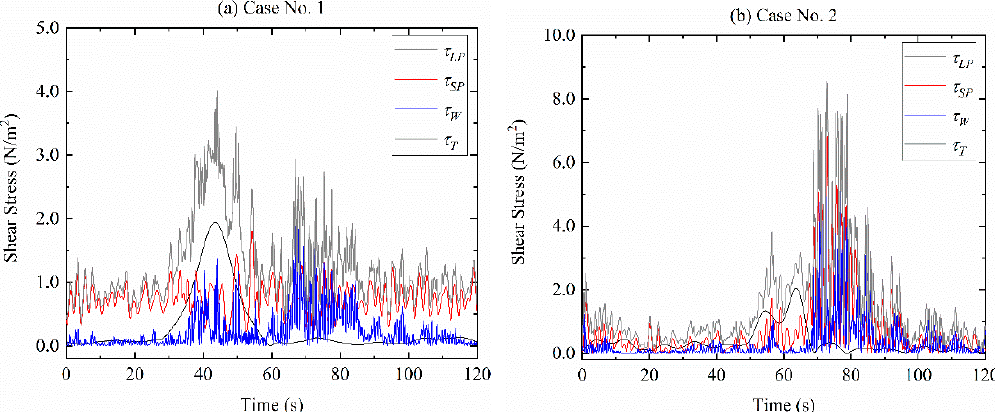
Figure 6. Bottom shear stress and its contributions of the primary wave, secondary wave and the turbulence caused by ( a ) Case No. 1 and ( b ) Case No. 2.